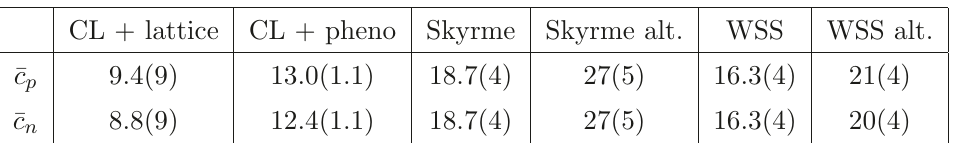
Table 1 . Values of the couplings of the axion with protons and neutrons, expressed in MeV times θ/f a . In the first and second columns the tree level Chiral Lagrangian (CL) result (4.21) is employed with the lattice results for the neutron-proton mass splitting and respectively lattice and phenomenological extractions for the pion-nucleon sigma term. The one-loop corrections increase these values by 5.5 MeV times θ/f a . In the third and fourth columns are reported the results (5.19) and (7.3) in the Skyrme model. In the fifth and sixth columns there are the values from (6.23) and (7.8) in the holographic WSS model. The latter results receive corrections from the instanton pseudo-moduli quantization, see appendix